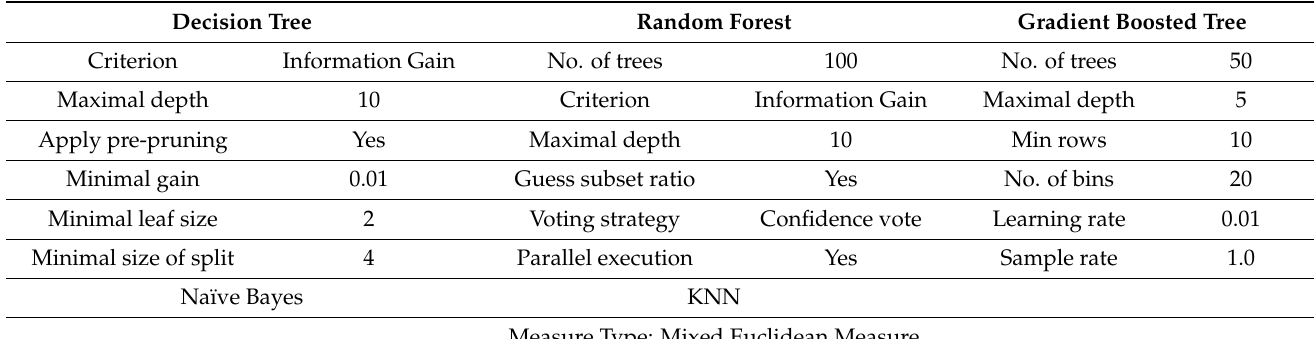
Table 2. The optimal model’s parameters used and achieved highest accuracy.